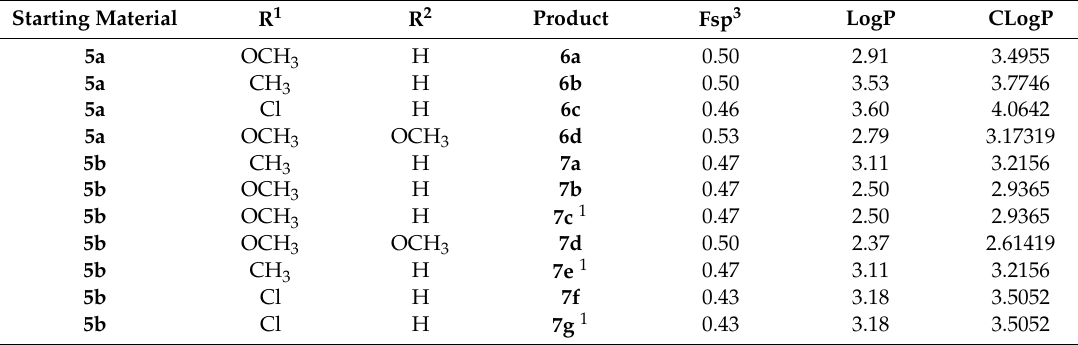
Table 1. Fsp 3 values of γ -oxocarboxylic acids.